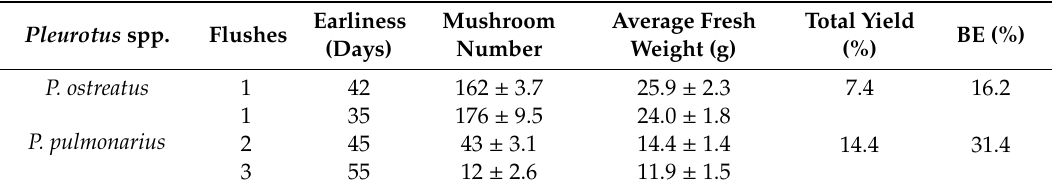
Table 3. Mushrooms yields and biological e ffi ciency (BE) of P. ostreatus and P. pulmonarius using grape pomace as